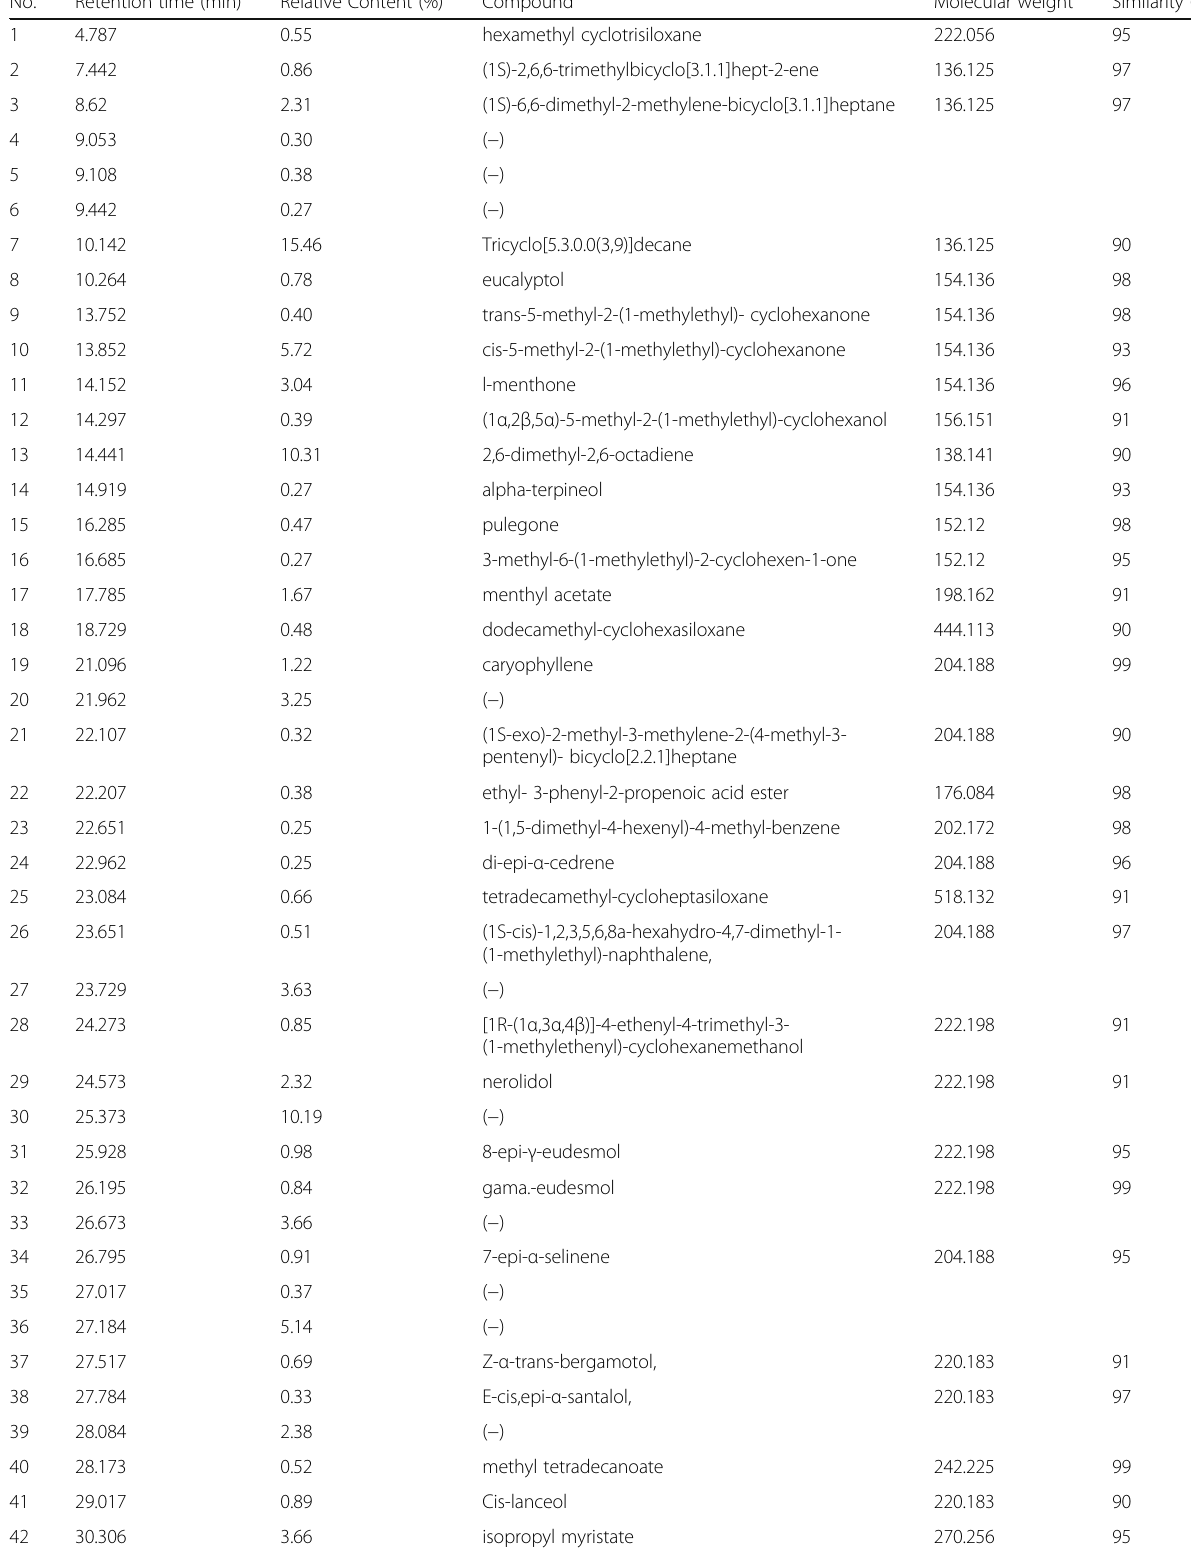
Table 1 Identified components of the compound essential